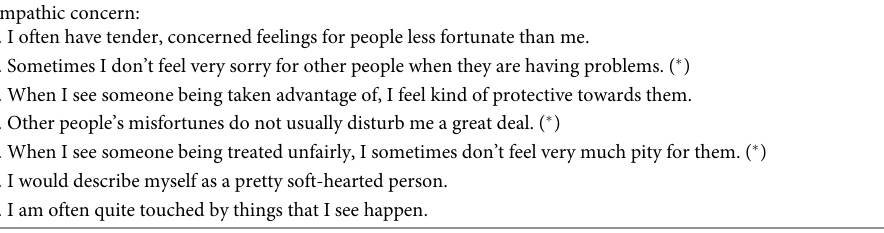
Table 1. Empathic concern and perspective taking subscales from Interpersonal reactivity